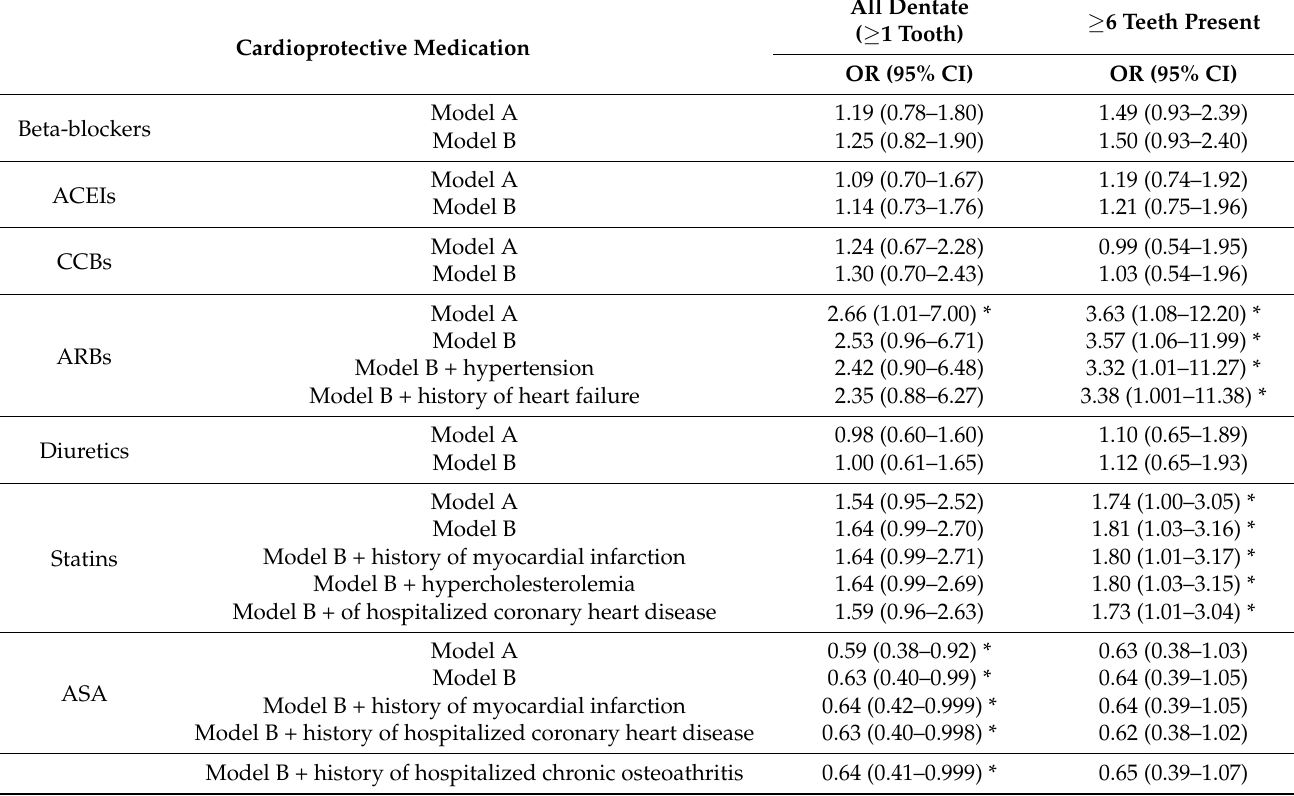
Table 5. Relationship between use of cardioprotective medications and prevalence of periodontitis (PD) (reference group: nonusers or users of other